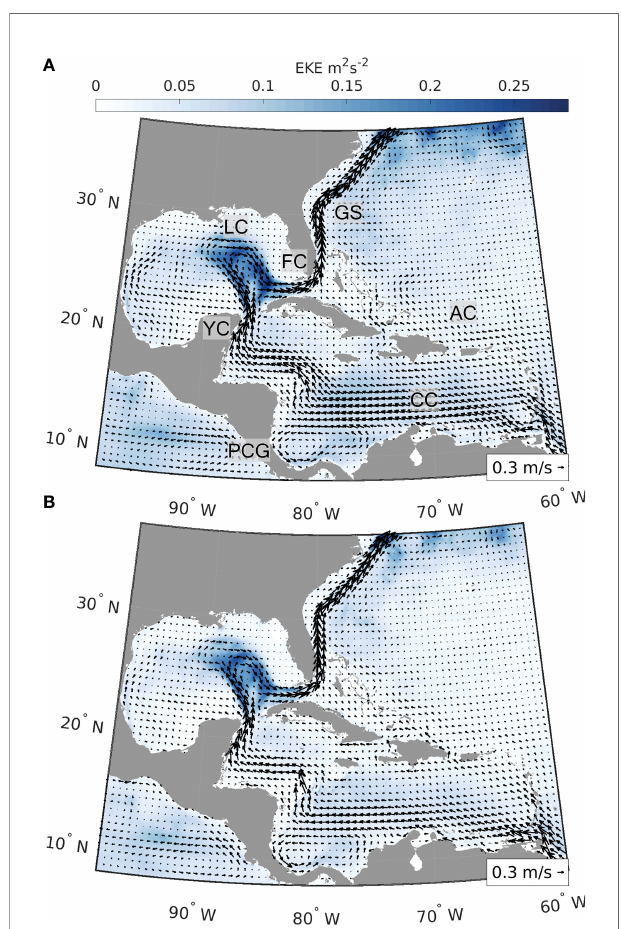
FIGURE 1 | Average surface velocity fi elds (m s -1 ) and eddy kinetic energy (EKE, m 2 s -2 ) for HYCOM reanalysis and analysis (A) and GLORYS12v1 reanalysis (B) . Figures are based on surface velocity fi elds from 2013 to 2017 (March to December), the same time period used for the simulations of dispersal. A span of 5 years was chosen to capture the interannual variability in the circulation and derived connectivity patterns. Arrows represent average surface velocity and background color the EKE. Labels in the top panel identify major oceanographic features in the region (CC, Caribbean Current; PCG, Panama-Colombia Gyre; YC, Yucata ́ n Current; LC, Loop Current; FC, Florida Current; GS, Gulf Stream; AC, Antilles